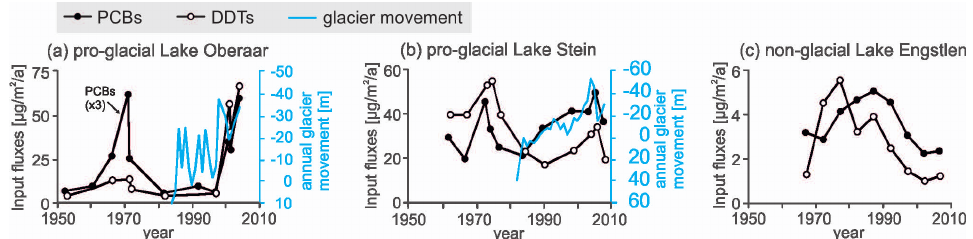
Fig. 3. Annual input fluxes of PCBs and DDTs (left y-axes) into sediment in three Swiss Alpine lakes including (a) the pro-glacial Lake Oberaar, (b) the pro-glacial Lake Stein, and (c) the non-glacial Lake Engstlen. For pro-glacial lakes (lakes immediately in front of or just beyond the limits of a glacier that are formed by or derived from glacier ice), the annual movement of the adjacent glacier is provided (right y-axes) with a positive value corresponding to a glacier growth and a negative value to a glacier retreat. Note that the values for PCBs in Lake Oberaar have been multiplied by three to fit to the y-axis scale. Figure adapted from Bogdal et al. (2009) and Schmid et al.